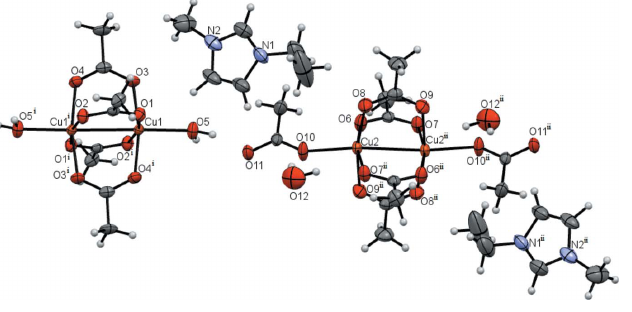
Figure 4 Compound 4 with displacement ellipsoids drawn at the 50% probability level. [Symmetry codes: (i) 2 (cid:2) x , 1 (cid:2) y , (cid:2) z ; (ii) (cid:2) x , (cid:2) y , 1 (cid:2) z .]